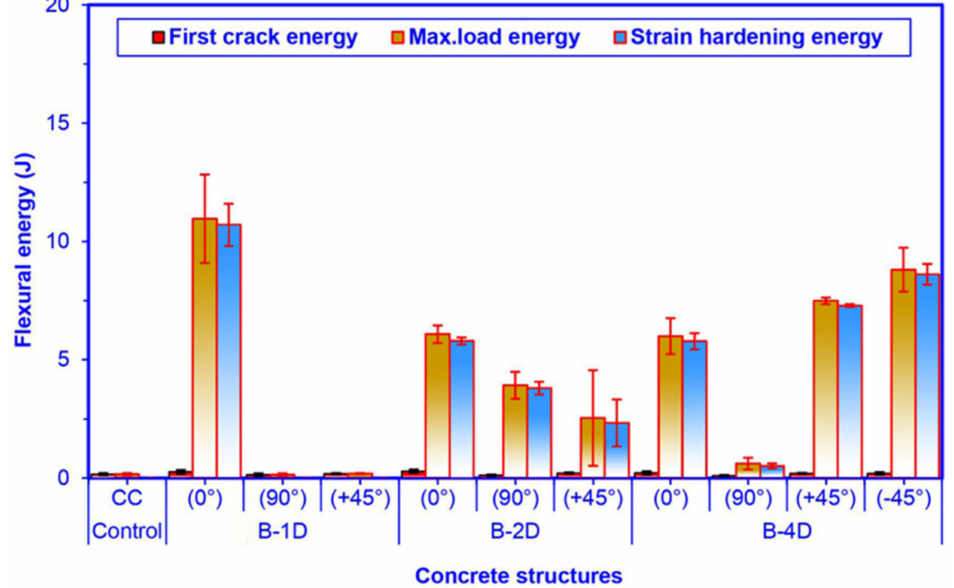
Figure 14. Off-axis flexure energy, first crack energy and strain-hardening energy of all multiaxis 3D basalt fiber TOW